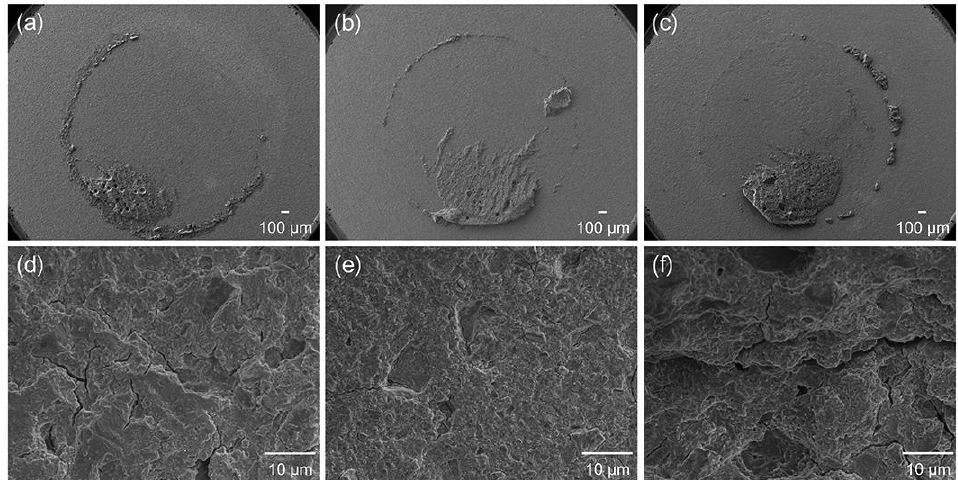
Figure 3. Representative SEM images of the fracture mode (RelyX U200) (magnification: upper: 30 × ; lower 2000 × ): ( a ) and ( d ): mechanical load cycling (MLC); ( b ) and ( e ): thermal cycling (TC) / MLC; ( c ) and ( f ): MLC / TC.